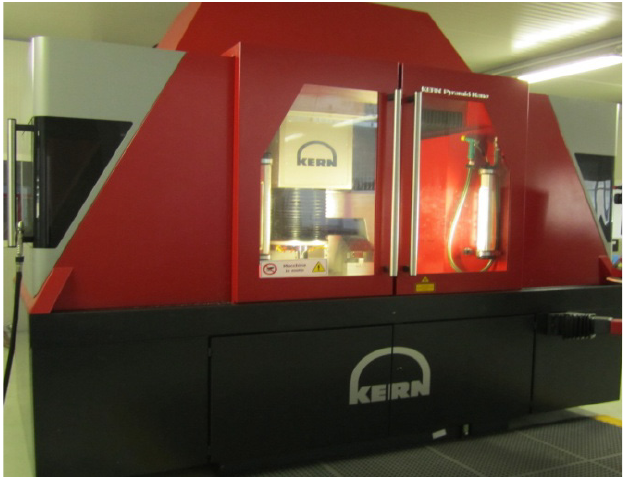
Figure 5. KERN pyramid nano-machining center.